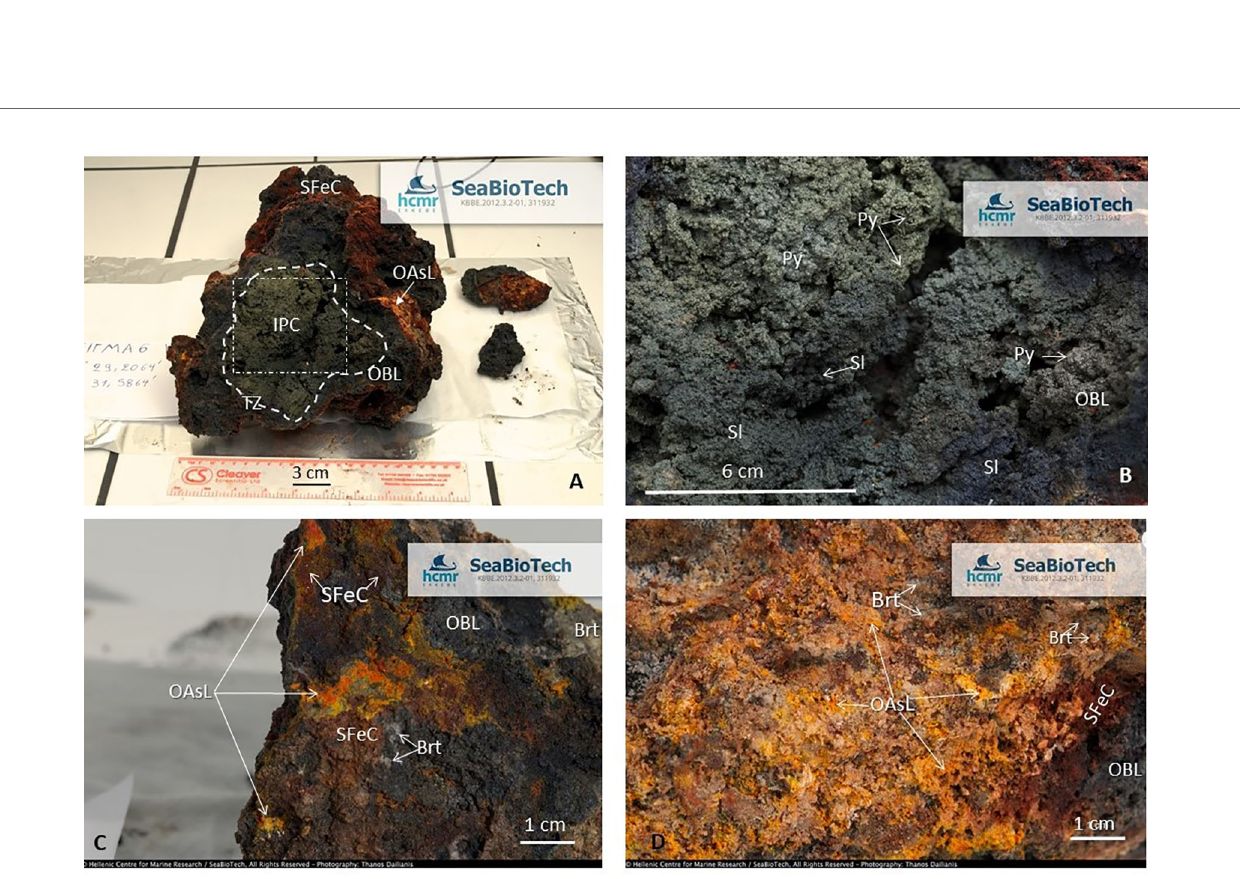
FIGURE 4 | Ex situ photographs of a typical recovered Au-rich SMS chimney (Au up to 32 ppm; Au/(Cu+Zn+Pb) = 1.9), enriched in potentially toxic, volatile metal (loid)s (As, Sb, Pb, Ag, Hg, Tl) (VTML), Kolumbo hydrothermal vent fi eld (Kilias et al., 2013). All sul fi de phases are variably enriched in Au and VTML. (A) . Basal cross section of chimney showing typical pattern of sul fi de phase zonation. (B) Enlargement of the squared area of (A) , showing the IPC texture that is dominated by fi ne- grained botryoidal masses of pyrite surrounding fl uid fl ow channels. (C, D) . Outermost skin of the OBL (dark bluish-black), composed of patches with red, orange, and yellow auriferous orpiment-, and realgar-, like phases (OAsL), associated with barite; these As-phases show evidence of oxidative weathering in the form of local, dark brown SFeC. Py, Auriferous As-pyrite; Brt, barite; Sl, polymetallic sul fi de aggregates; IPC, Inner Pyrite Core; OBL, Outermost Barite Layer; TZ, Transition Zone; OAsL, Outer As-rich Layer; SFeC, Surface Fe-oxyhydroxide rich Crust. “ SeaBioTech ” EU-FP7 project (Grant No. 311932), are thanked for funding the